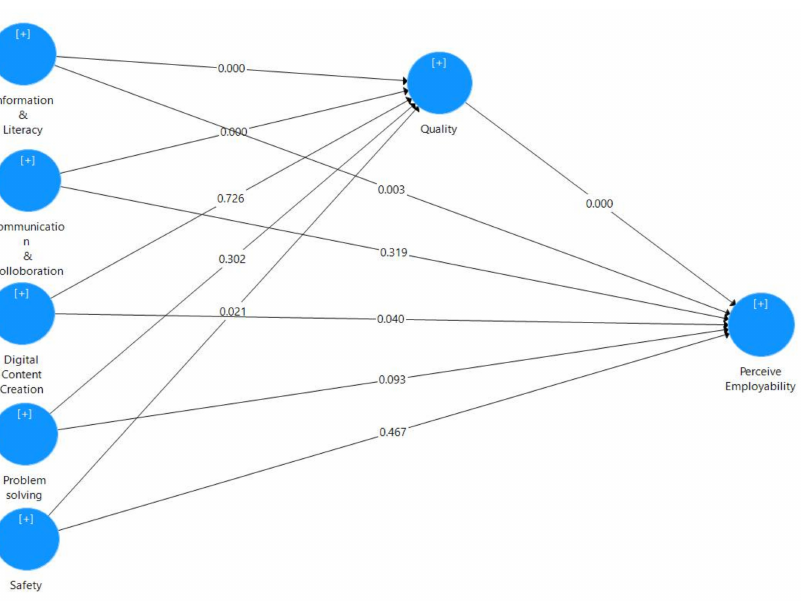
Figure 1. Structural